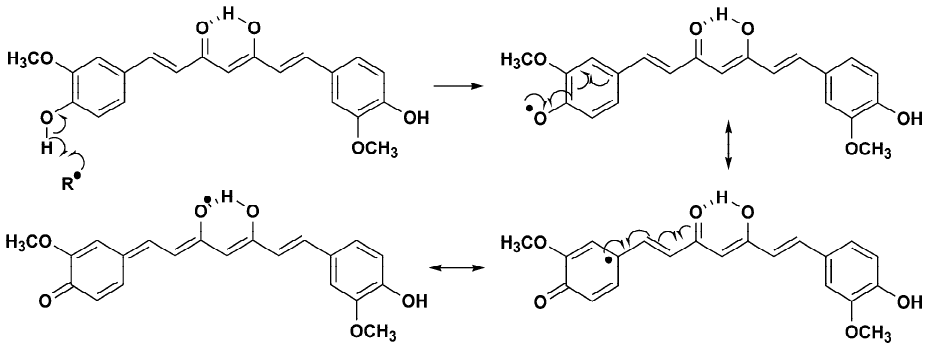
Figure 8. Phenolic group as radical source in the curcumin molecule.